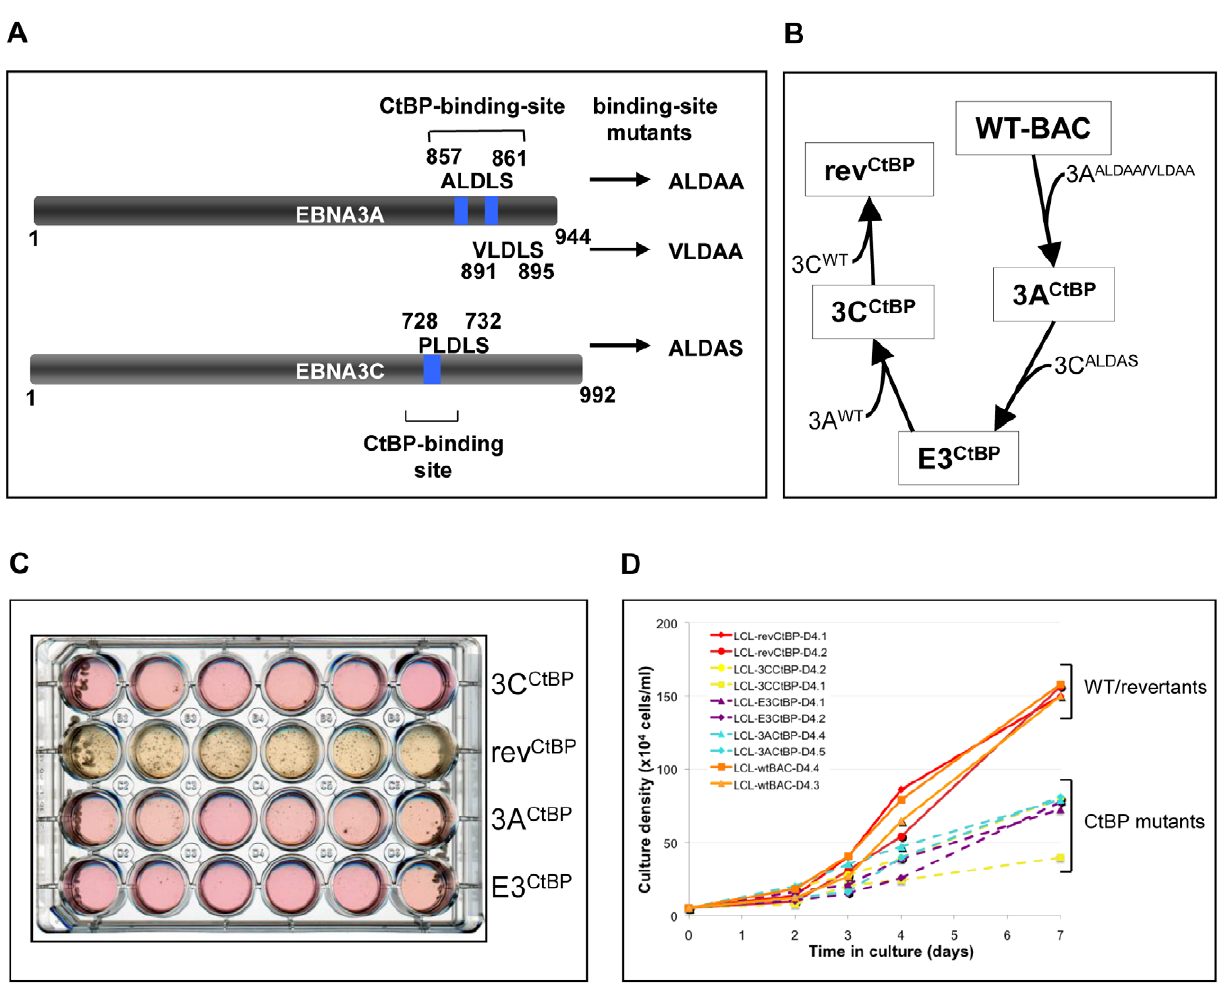
Figure 8. LCLs expressing CtBP-binding mutants of EBNA3A and EBNA3C grow relatively poorly. ( A ) Schematic showing mutations of CtBP-binding sites in EBNA3A and EBNA3C that were introduced into the CtBPM recombinant viruses. EBNA3C includes a single consensus PLDLS site that was mutated to ALDAS [16]. EBNA3A includes two non-canonical CtBP-binding sites that synergise to produce very efficient binding to CtBP; the ALDLS site was mutated to ALDAA and the VLDLS site was mutated to VLDAA [17]. ( B ) Schematic showing the generation of a series of CtBP-binding mutant EBVs, by serially mutating the EBNA3 CtBP binding sites, and then reverting them, creating both single and double CtBP mutant EBVs, and a revertant. ( C ) A plate of cells 40 days after infection of PBLs with 1000 rgu of virus per well. Difference in the colour of the medium and the visible density/size of cell clumps in the wells are clear indicators that CtBP-mutant LCLs grow out more slowly than wild-type (not shown) and revertant LCLs. This appears to be more striking in 3C CtBP and E3 CtBP LCLs. ( D ) Established LCLs (approximately 3 months post-infection) were seeded at 5 6 10 4 cells/ml and counted each day for a week. CtBP-mutants (dashed lines) grow more slowly, and/or have a lower maximum cell density than wild-type and revertant LCLs (solid lines). Two cell lines were tested for each